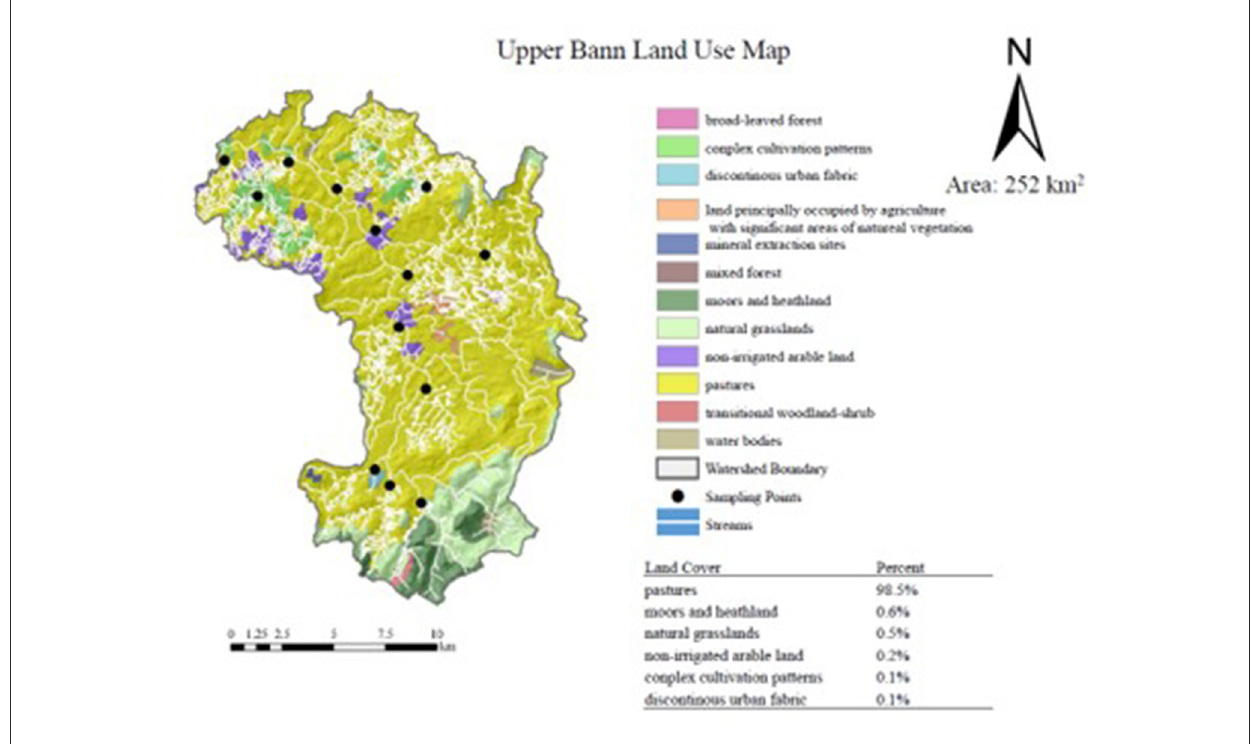
FIGURE3 Upper Bann land use